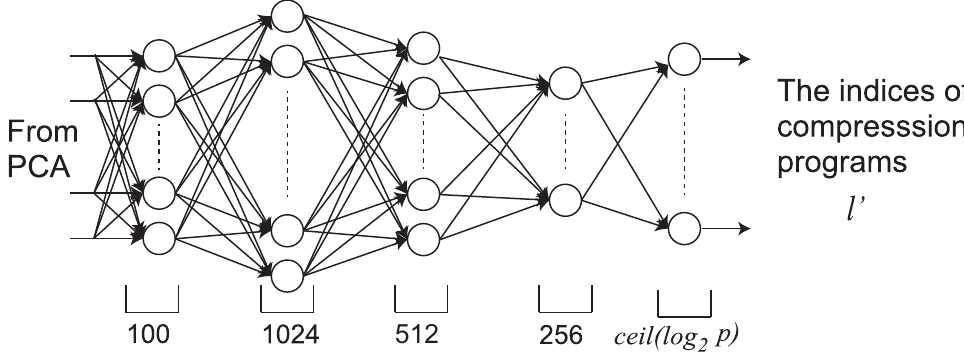
Figure 2. The structure of the DNN used for the inference of the compression algorithms.